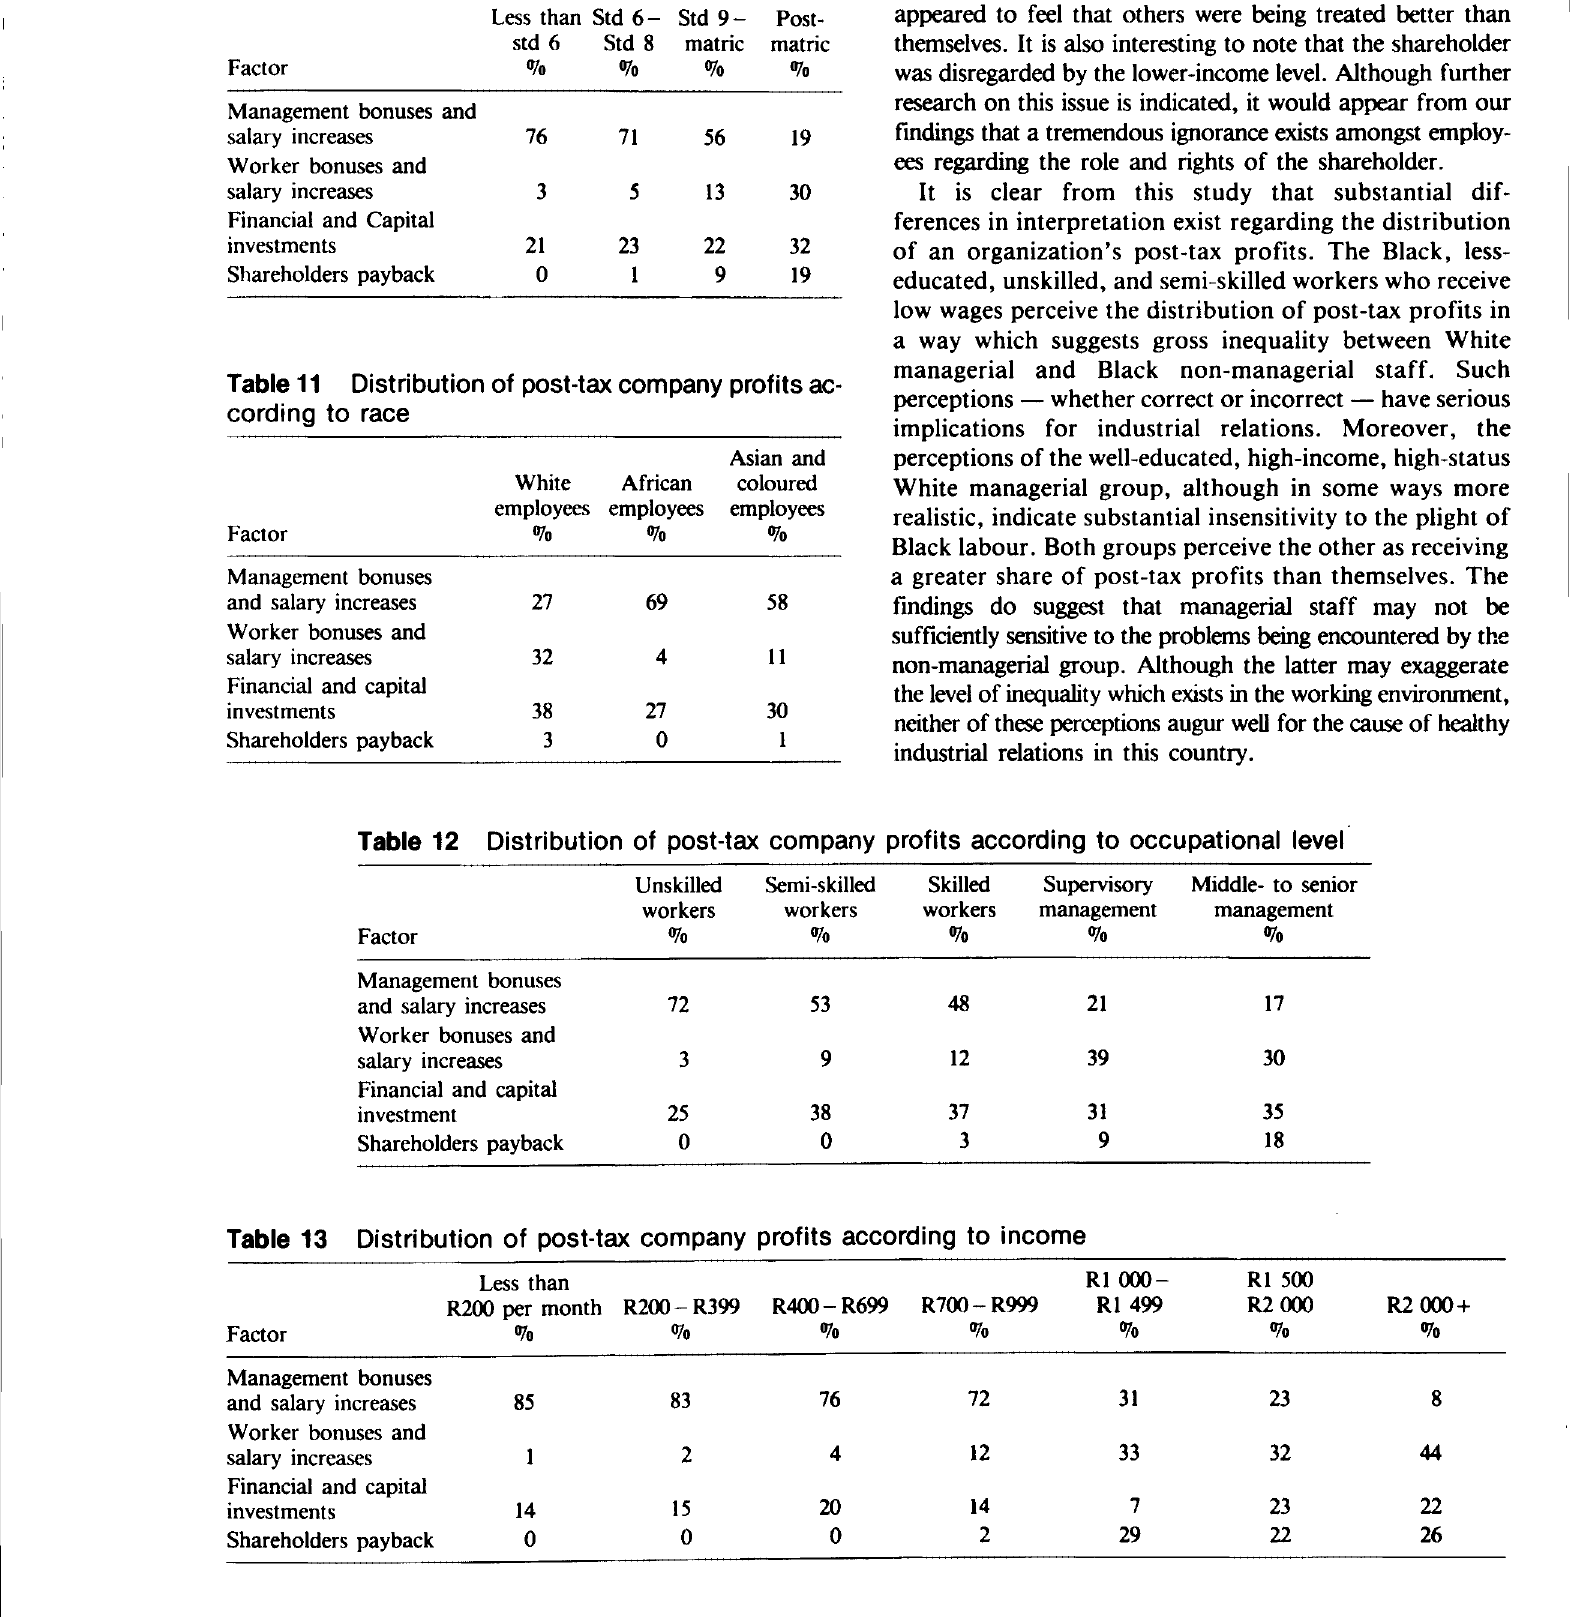
Distribution of post-tax company profits according to